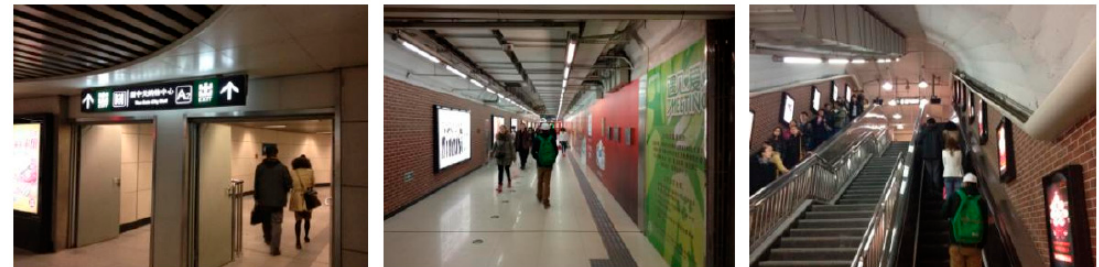
Figure 1. Examples of tubular spaces in subway station building complexes.